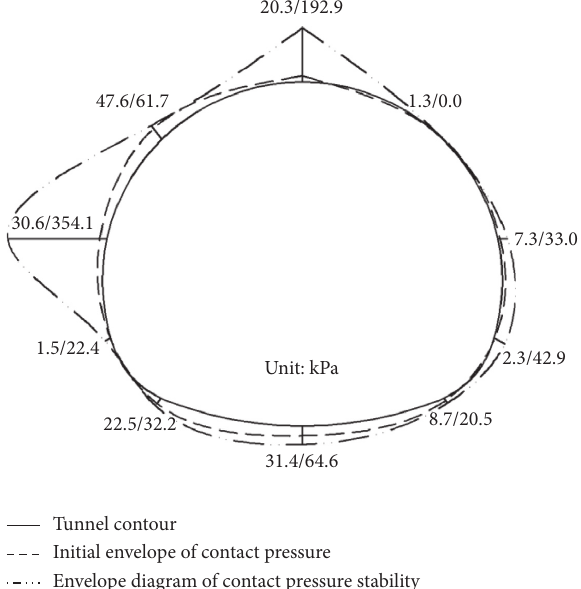
Figure 7: DK-190+617 mileage surrounding rock pressure en- velope diagram of Zaosheng Tunnel.